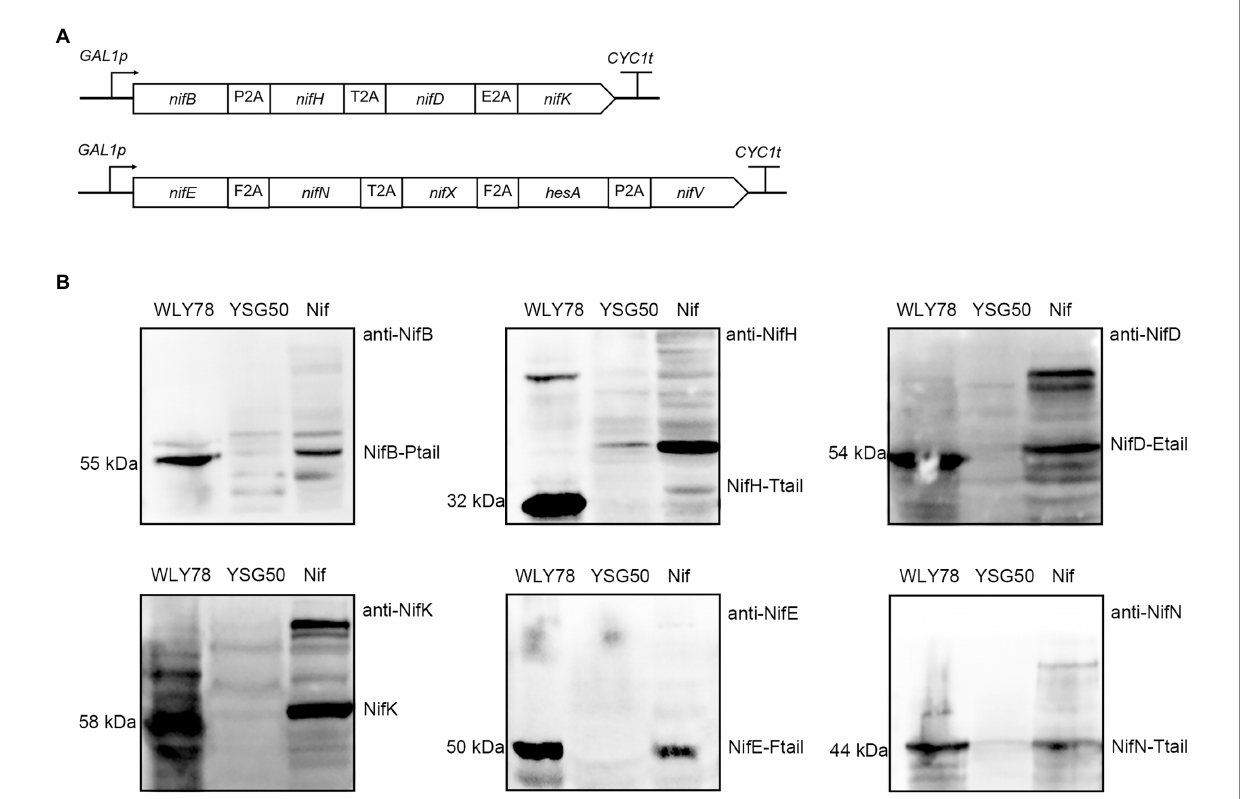
FIGURE 2 Co-expression of nine Nif proteins in yeast. (A) Schematic diagrams of the constructs of nine genes linked via different 2A peptides in the recombinant vectors. The four genes ( nifB , nifH , nifD , and nifK ) were linked by P2A, T2A, and E2A peptides, and cloned into pRS423- GAL1p . The five genes ( nifE , nifN , nifX , hesA , and nifV ) fused by F2A, T2A, F2A, and P2A peptides, and inserted into pRS424- GAL1p . All of the nif genes were under the control of GAL1 promoter. (B) Western blotting analysis of the recombinant S . cerevisiae Nif containing nine Nif proteins with anti-NifB, anti-NifH, anti-NifD, anti- NifK, anti-NifE and anti-NifN. GAL1p indicates promoter and CYC1t indicates terminator. WLY78, P . polymyxa WLY78 as a positive control; YSG50, S . cerevisiae YSG50 as a negative control; Nif, S . cerevisiae Nif.